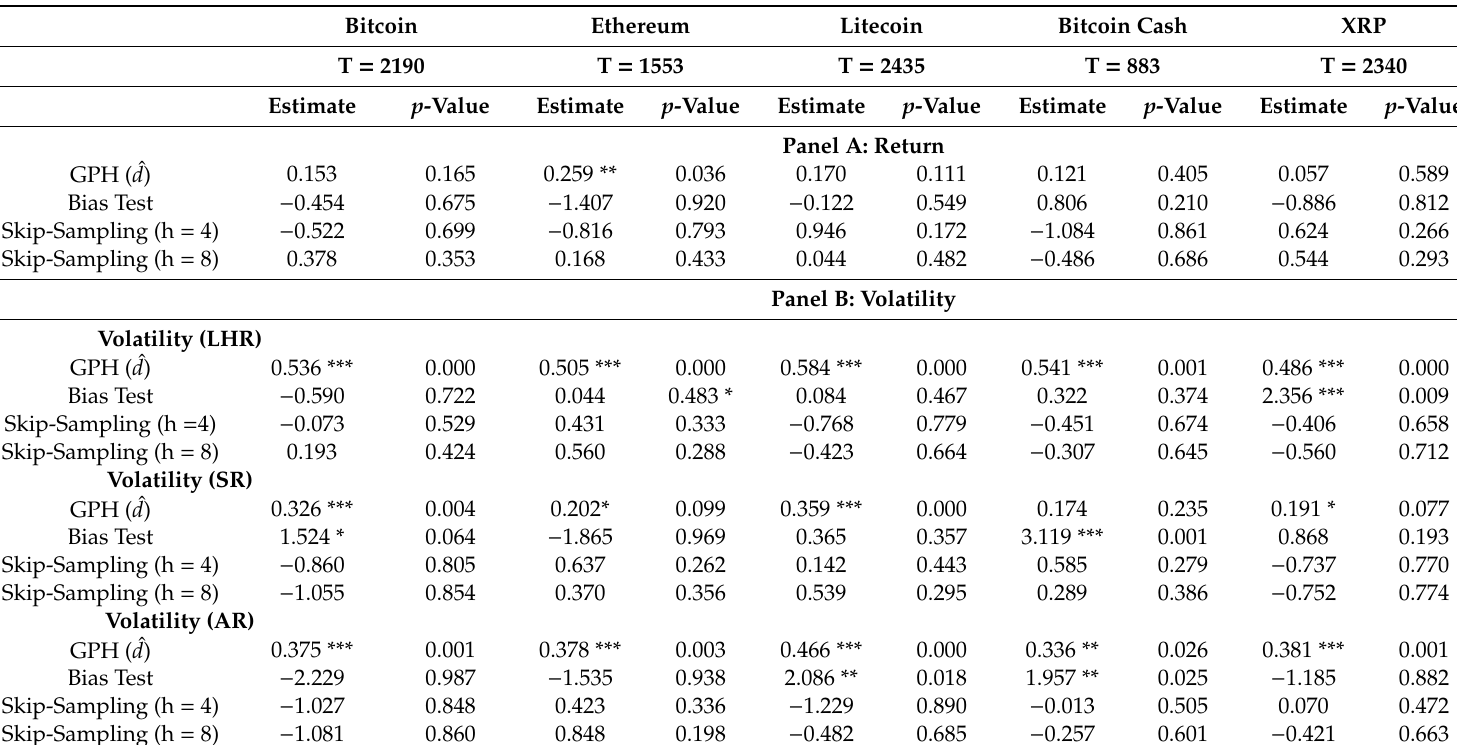
Table 3. Long Memory Tests. The table reports the long memory test results for the five most common cryptocurrencies. Panel A exhibits the GPH estimates, bias test, and skip-sampling tests with di ff erent rates of h = 4, 8 months for returns. Panel B shows the results for three measures (i.e., proxies) of volatility: daily low high range (LHR), squared returns (SR), and absolute returns (AR). The two skip-sampling rates were chosen in favor of producing results with a narrow bandwidth. T is the sample size in number of